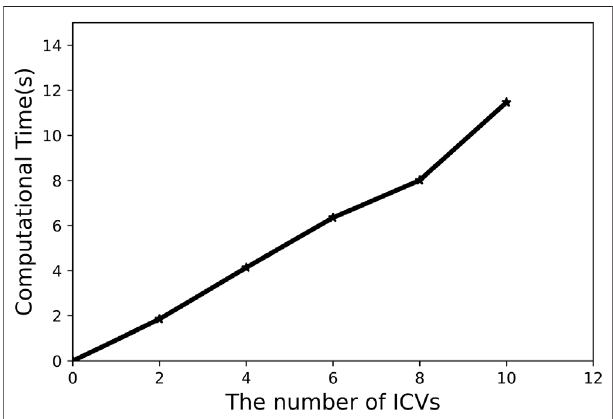
FIGURE 7 | Computational time of